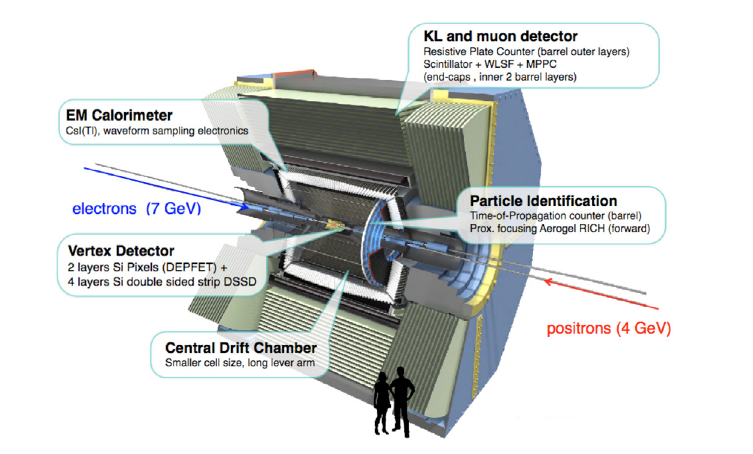
Figure 1. Overview of the Belle II